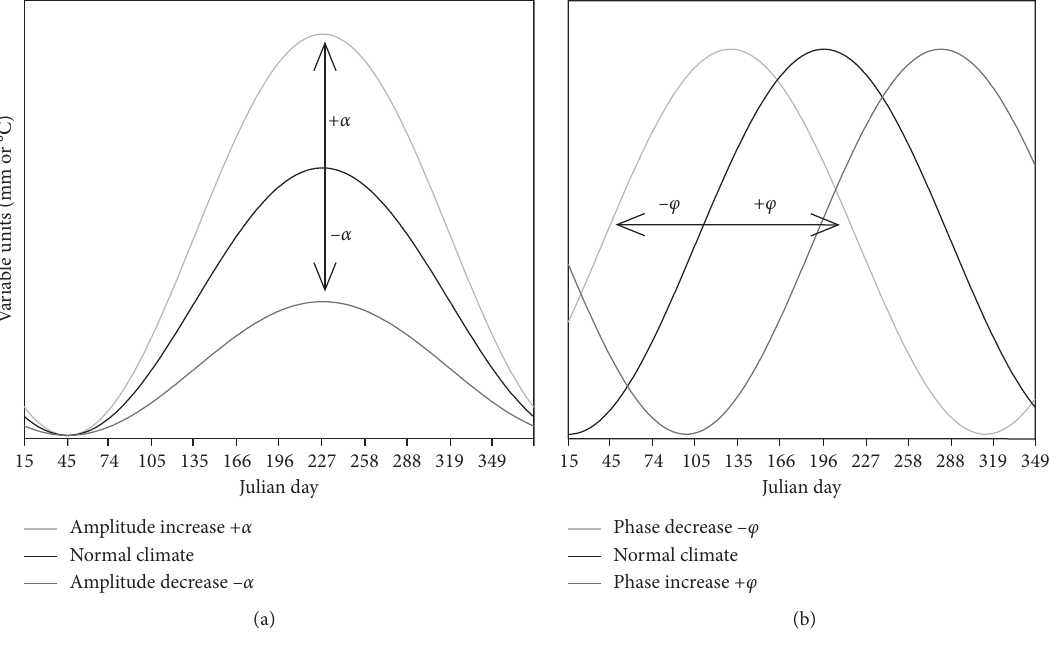
Figure 3: Interpretation of (a) amplitude ( α ) and (b) phase ( φ